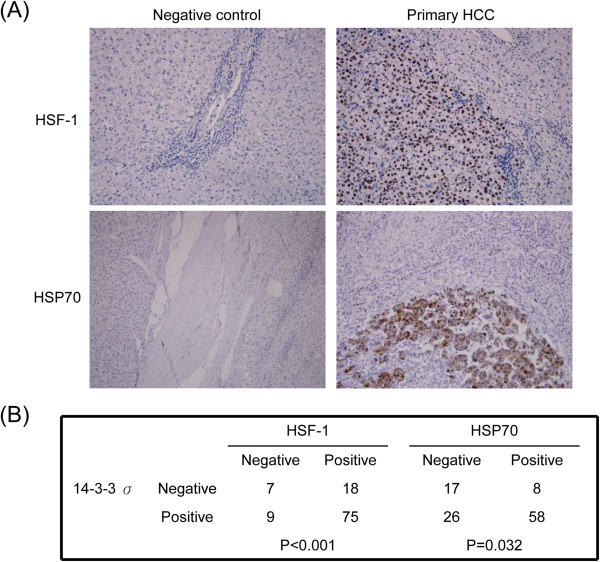
Correlation of 14-3-3σ expression with HSF-1 and HSP70 in HCC tumors. (A) Representative expression of HSF-1 and HSP70 in primary HCC tumors as well as negative control was examined by immunohistochemical analysis. Original magnification, ×200. (B) 14-3-3σ significantly correlates with HSF-1 and HSP70 expression in primary HCC tumors as analyzed by the Chi-square test.